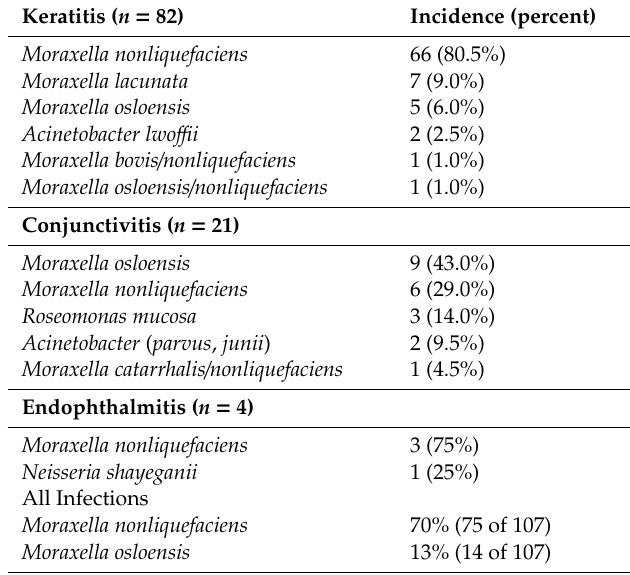
Table 2. The Identification of Moraxella to species as isolated from keratitis, conjunctivitis, and endophthalmitis